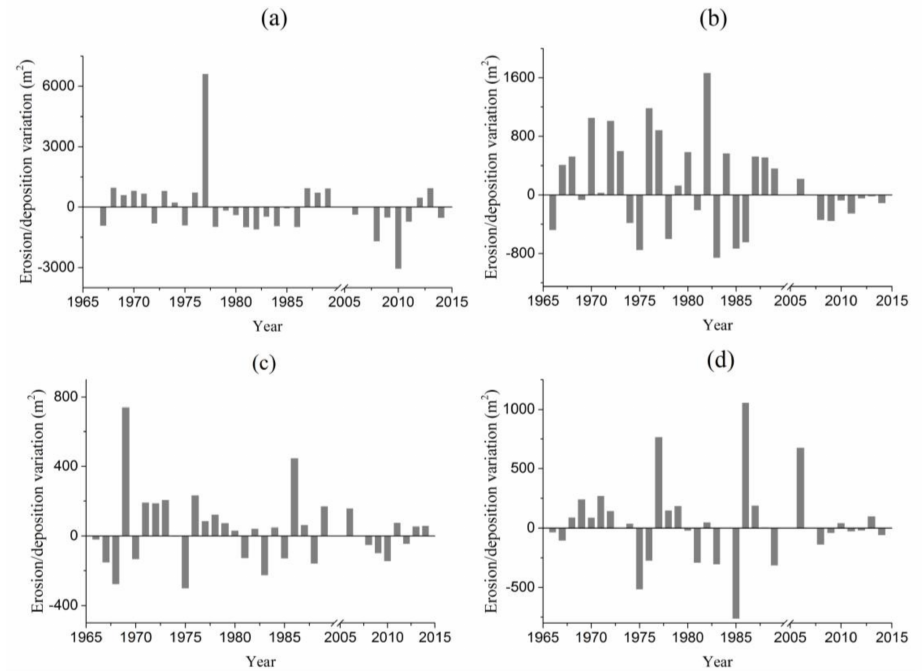
Figure 4. Changes of annual erosion/deposition in sections of Jiahetan ( a ), Gaocun ( b ), Luokou ( c ) and Lijin ( d ) in the lower Yellow River.